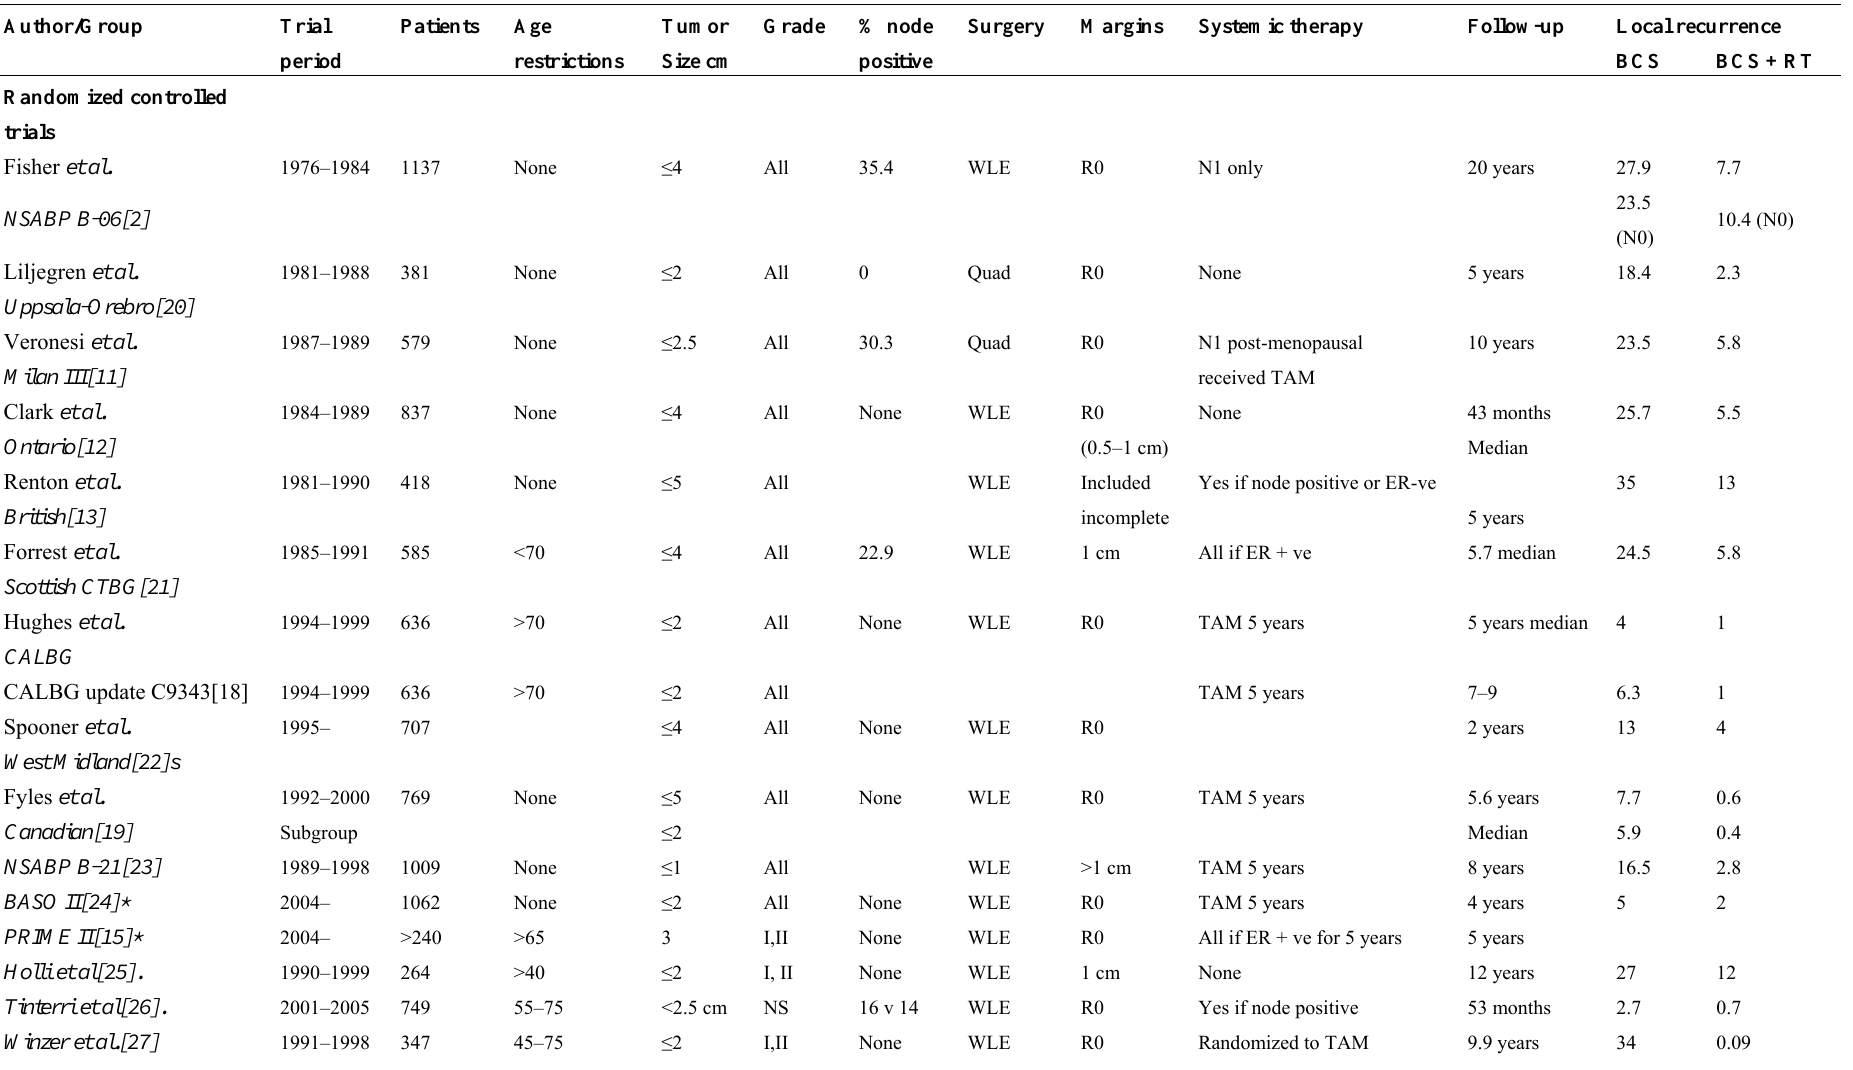
Table 1. Summary of randomized controlled trials evaluating omission of radiotherapy in early breast